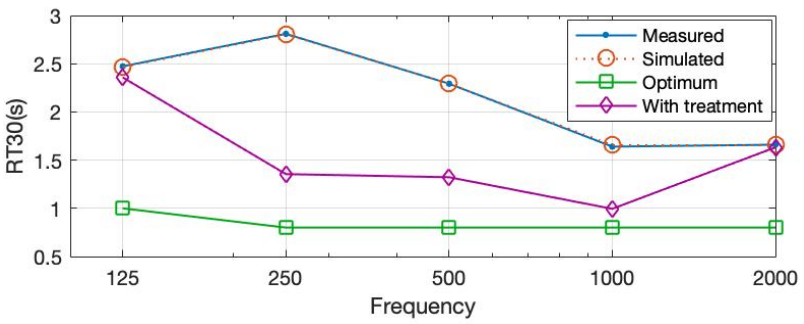
Figure 13. RT30 values after the proposed material is used as treatment compared to optimum and existing values.